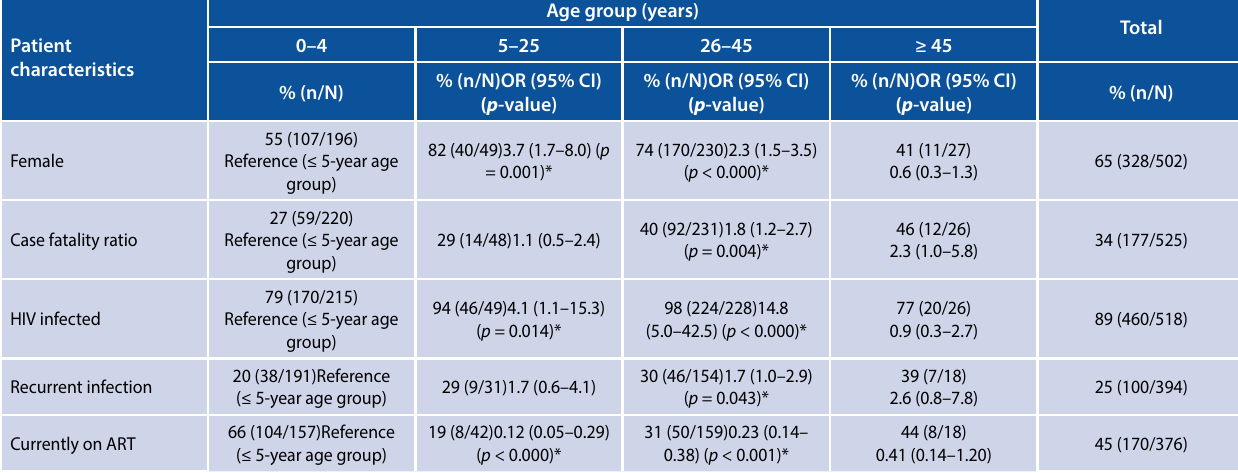
Note: ART: antiretroviral therapy, HIV: human immunodeficiency virus * : Statistically significant difference compared with ≤ 5-year age group